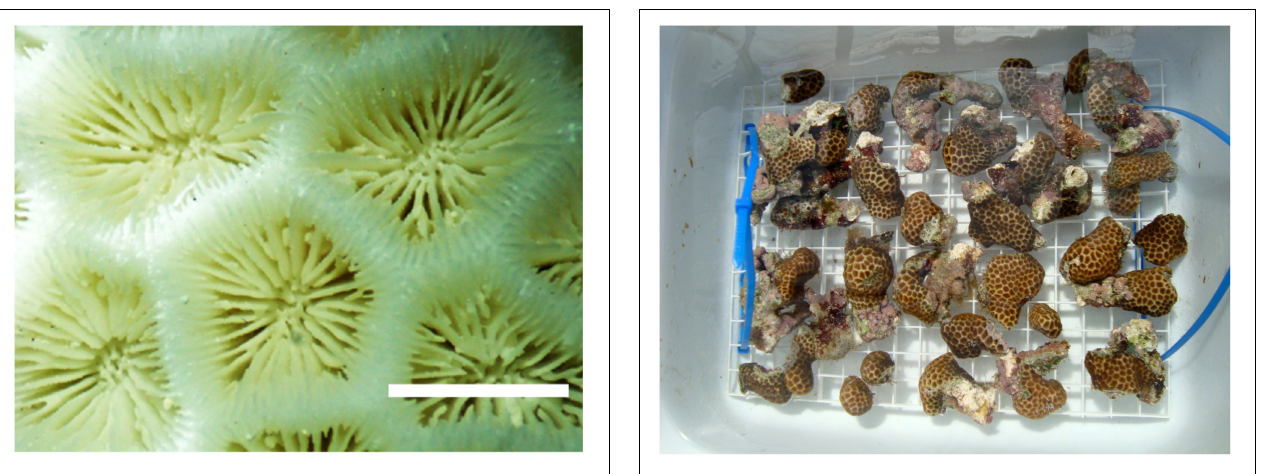
FIGURE 2 | Corallites of Leptastrea purpurea . Scale bar: 5 mm. FIGURE 3 | Adult colonies placed onto an egg-crate tray to minimize